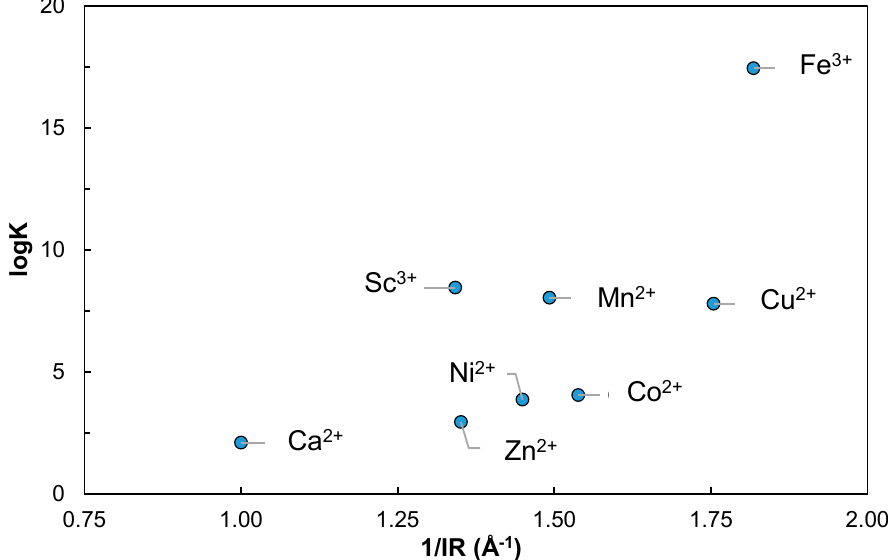
Figure 7. Comparison of log β for M-Heparin complexes from Feofanova et al. [65] (Zn 2+ , Cu 2+ , Ni 2+ , Co 2+ , and Fe 3+ ), Rendleman [67] (Ca 2+ ), and Sc-heparin in this work, as a function of the inverse effective ionic radius 1/IR [69].